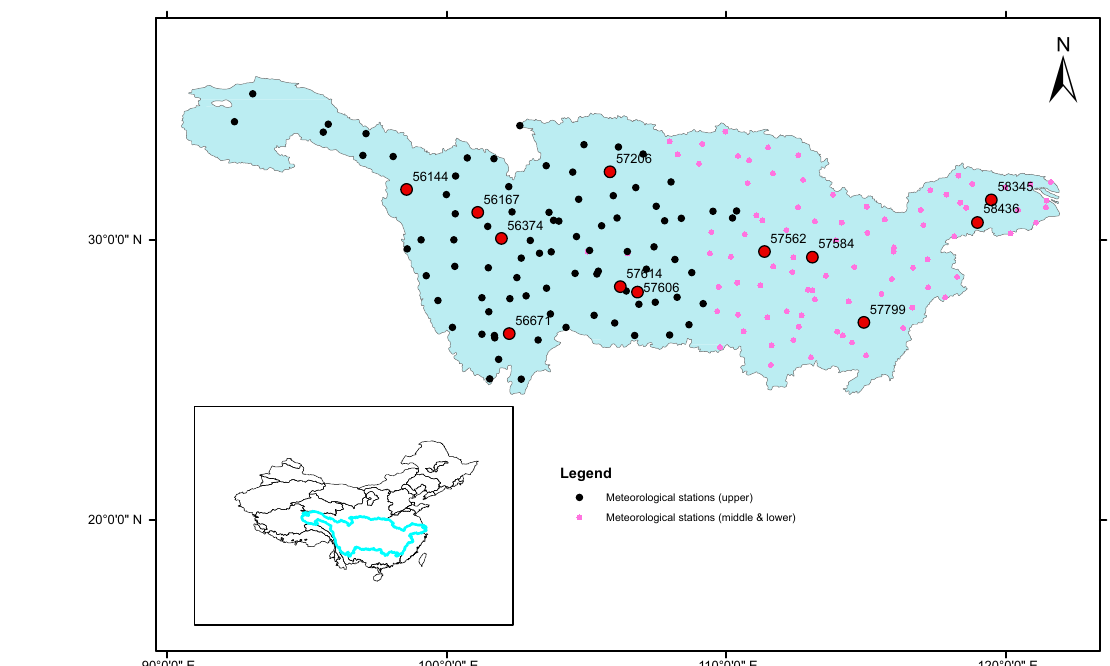
Figure 1. Locations of meteorological stations on the map of Yangtze River Basin.